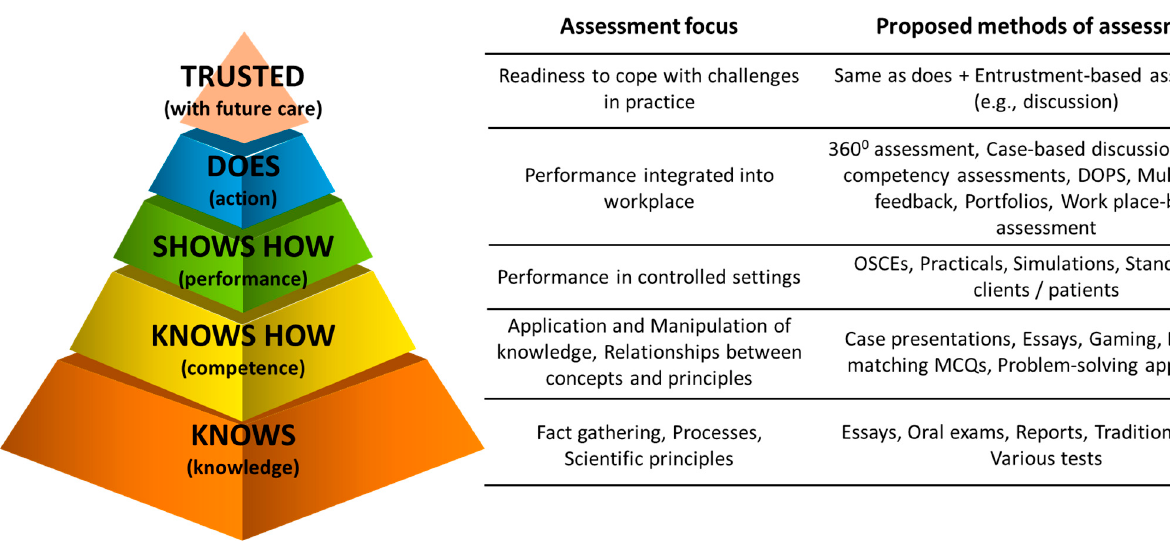
Figure 1. Extended Miller’s pyramid of clinical competence of learners that can be useful to frame minds of veterinary instructors when assessing learners or planning learning and assessment activities (Modified from [13,14]). DOPS—Direct Observation of Procedural Skills. MCQ—Multi Choice Question. OSCE—Objective Structured Clinical Examination.